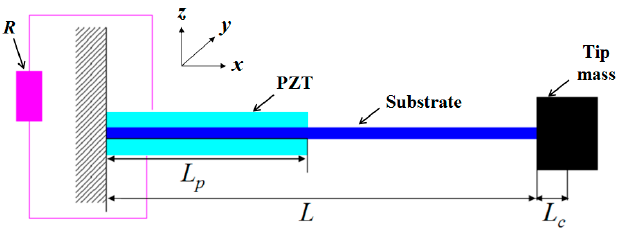
Figure 3. Linear piezoelectric energy harvester with the non-uniform cross-section in the NPEHS.